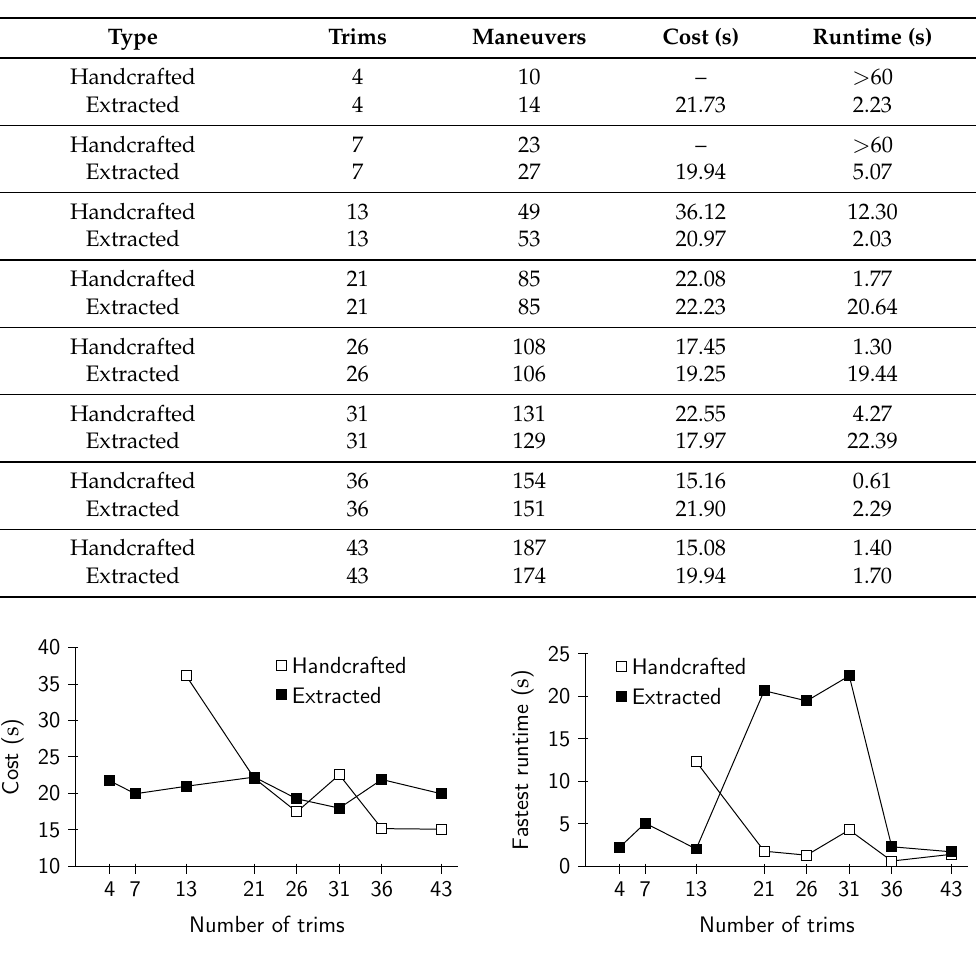
Table 2. Results for the handcrafted and extracted automata.